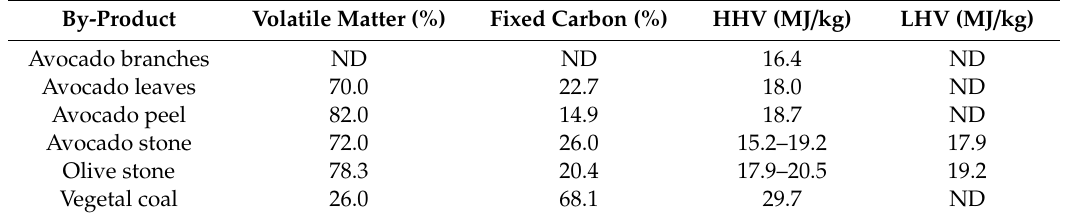
Table 3. Energetic characteristics of some avocado residues and other biomasses